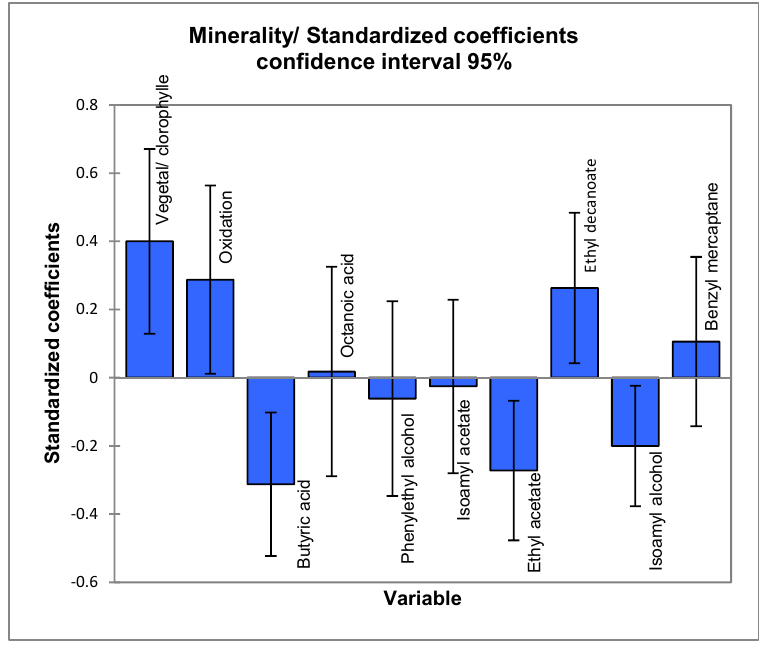
Figure 3. Standardized coefficients of the linear regression in the predictive model of aromatic “minerality” descriptor constructed according to the chemical and sensory profile of the seventeen wine samples of the study.